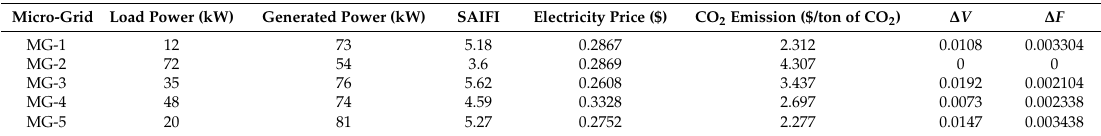
Table 1. Data of the distributed network under Study.